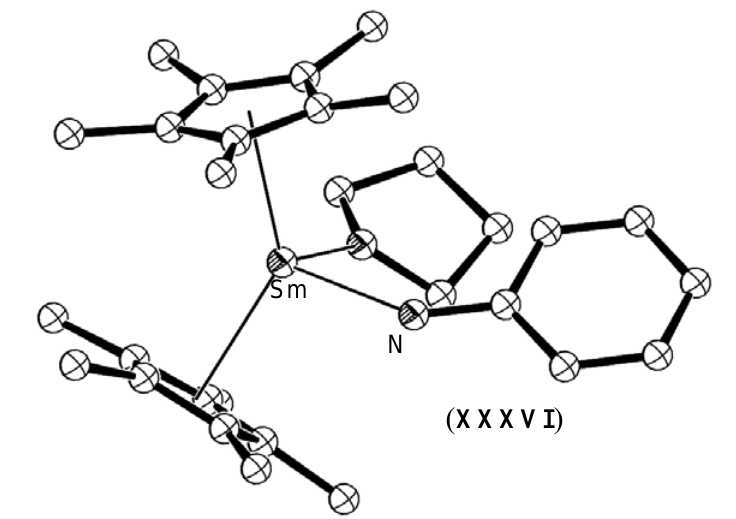
Figure 14. Molecular structure of [(C generated from CCDC obtained coordinates. Atoms of arbitrary size. H atoms are omitted for